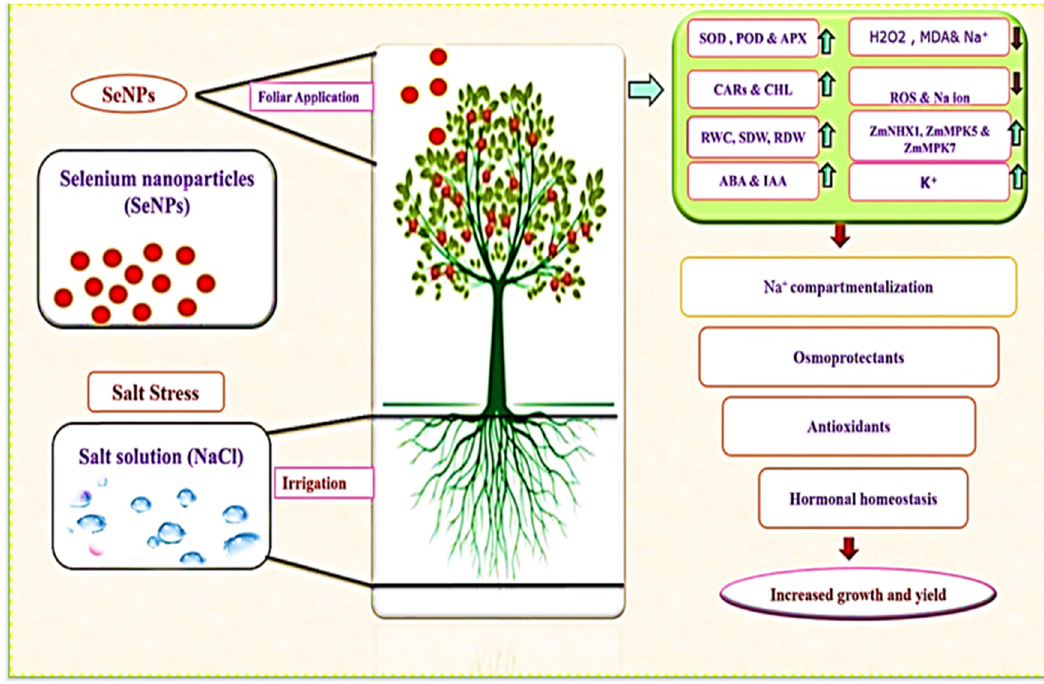
Figure 2: Schematic diagram demonstrating the possible mechanisms of salinity stress tolerance in plants induced by plant - mediated SeNPs. Under salinity stress, foliar applications of plant - mediated SeNPs on plants enhance growth and yield parameters by ( i ) protecting photosynthetic pigments to improve photosynthetic capacity; ( ii ) maintaining ROS homeostasis by activating antioxidant defense system - related enzymes, e.g., SOD, POD, and APX; ( iii ) upregulating the expression of salt stress - related genes ZmMPK5, ZmMPK7, and ZmCPK11; ( iv ) enhancing abscisic acid ( ABA ) and indole - 3 acetic acid ( IAA ) concentrations for improvement of root biomass and continuation of the proper osmotic status of the cell; ( v ) inducing salt stress resistance by promoting RWC, shoot dry weight ( SDW ) , and root dry weight ( RDW ) , carotenoids ( CARs ) , and chlorophyll ( CHL ) contents, ( vi ) increasing the uptake of potassium ions ( K + ) and causing compartmentalization of sodium ions ( Na + ) [ 28 ] . Upward arrows show an increase and the downward arrows indicate a decrease in the respective